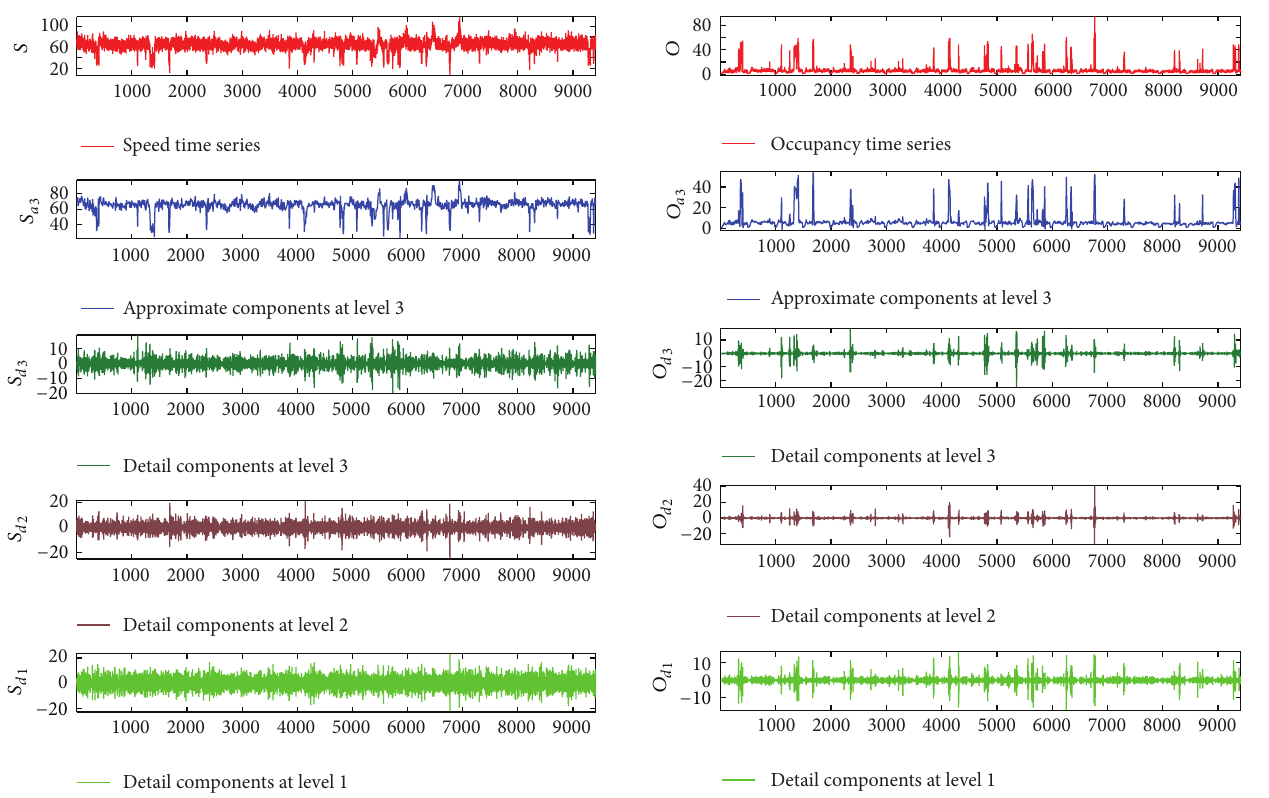
Figure 4: Speed time series wavelet decomposition at the 15th detector. Self-similarity is present at each decomposition level in wavelet decomposition diagrams on speed. Symbols qualitatively show the chaos existence in speed time series.